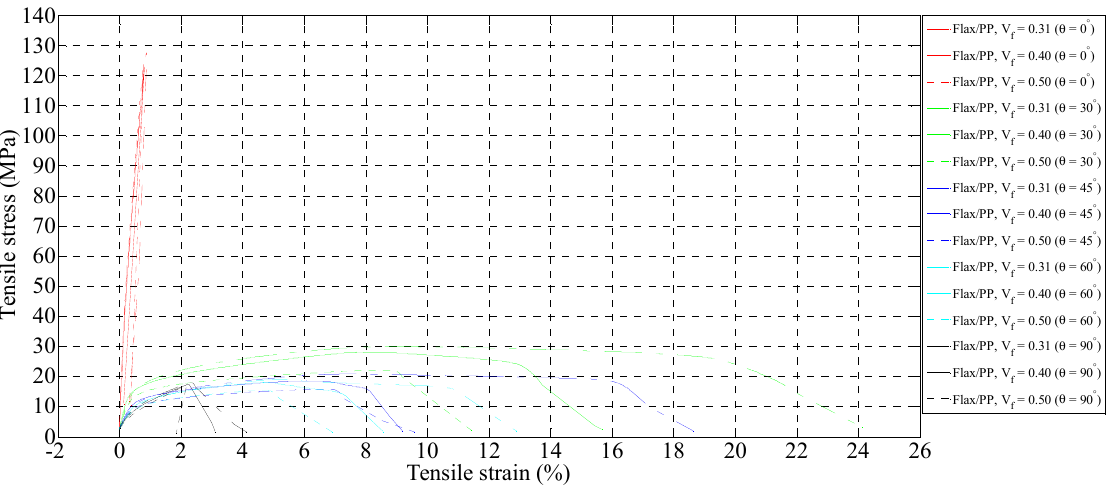
Figure 16. Representative stress-strain curves of flax/PP composite samples with different fibre